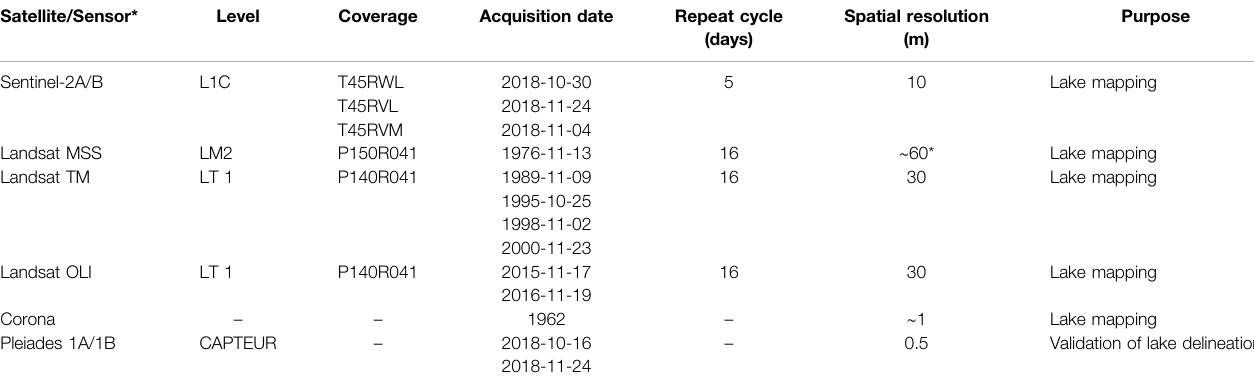
TABLE 1 | Details of satellite data used in this